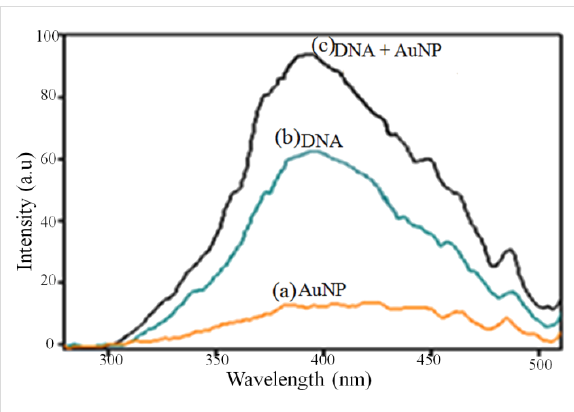
Figure 8: Fluorescence emission intensity of bare (a) AuNPs, (b) DNA and (c) AuNP–DNA composites.